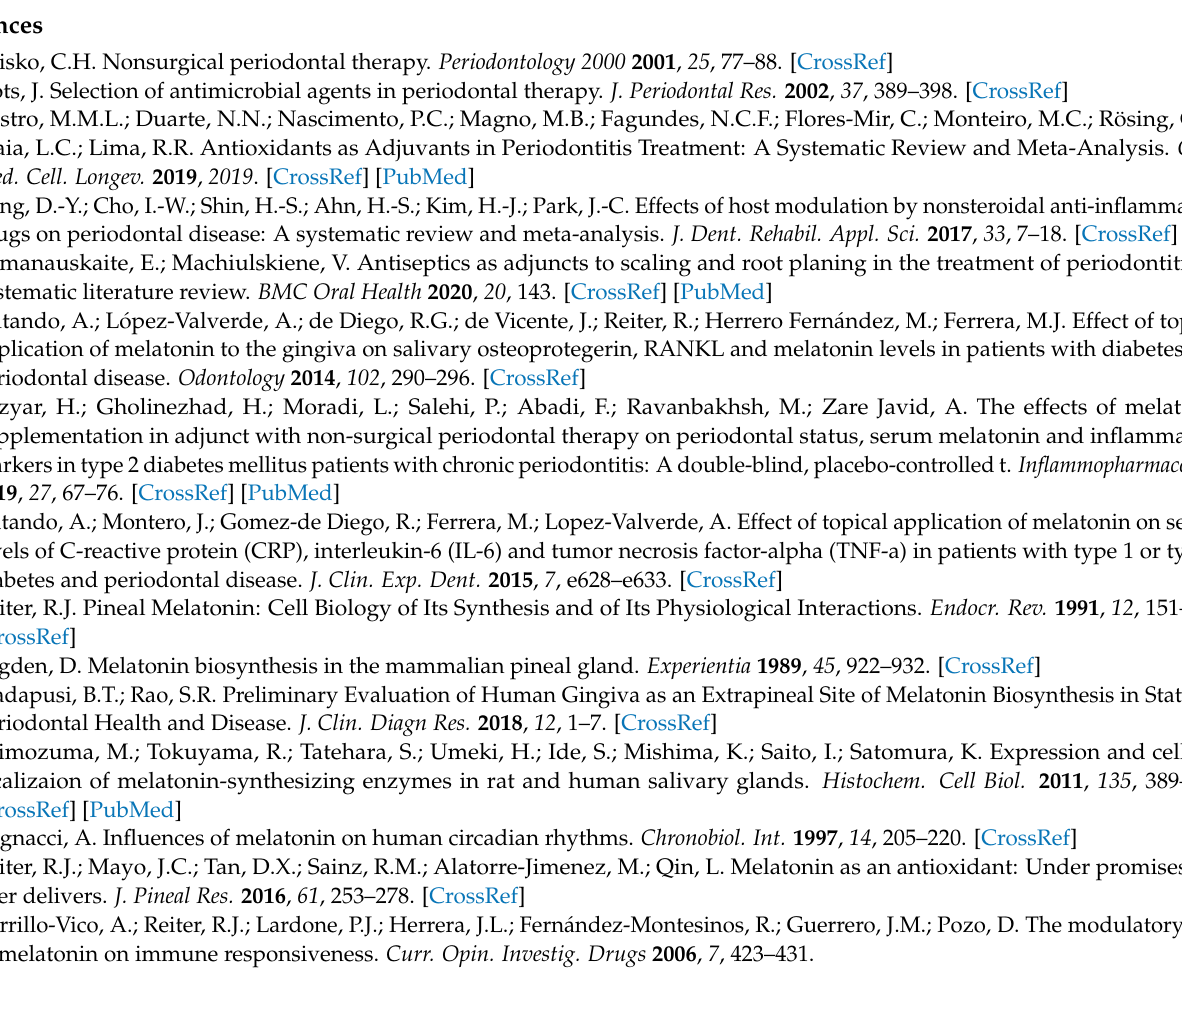
melatonin formulation, Table S2: Additional information on the included studies using systemic melatonin formulation, Table S3: Summary of the RoBANS assessment of the included studies, Table S4: Summary of the RoB tool-based assessment of the included studies, Table S5. Summary of the SIGN 50 scorings of the included studies, Table S6. Summary of the GRADE scoring of the included